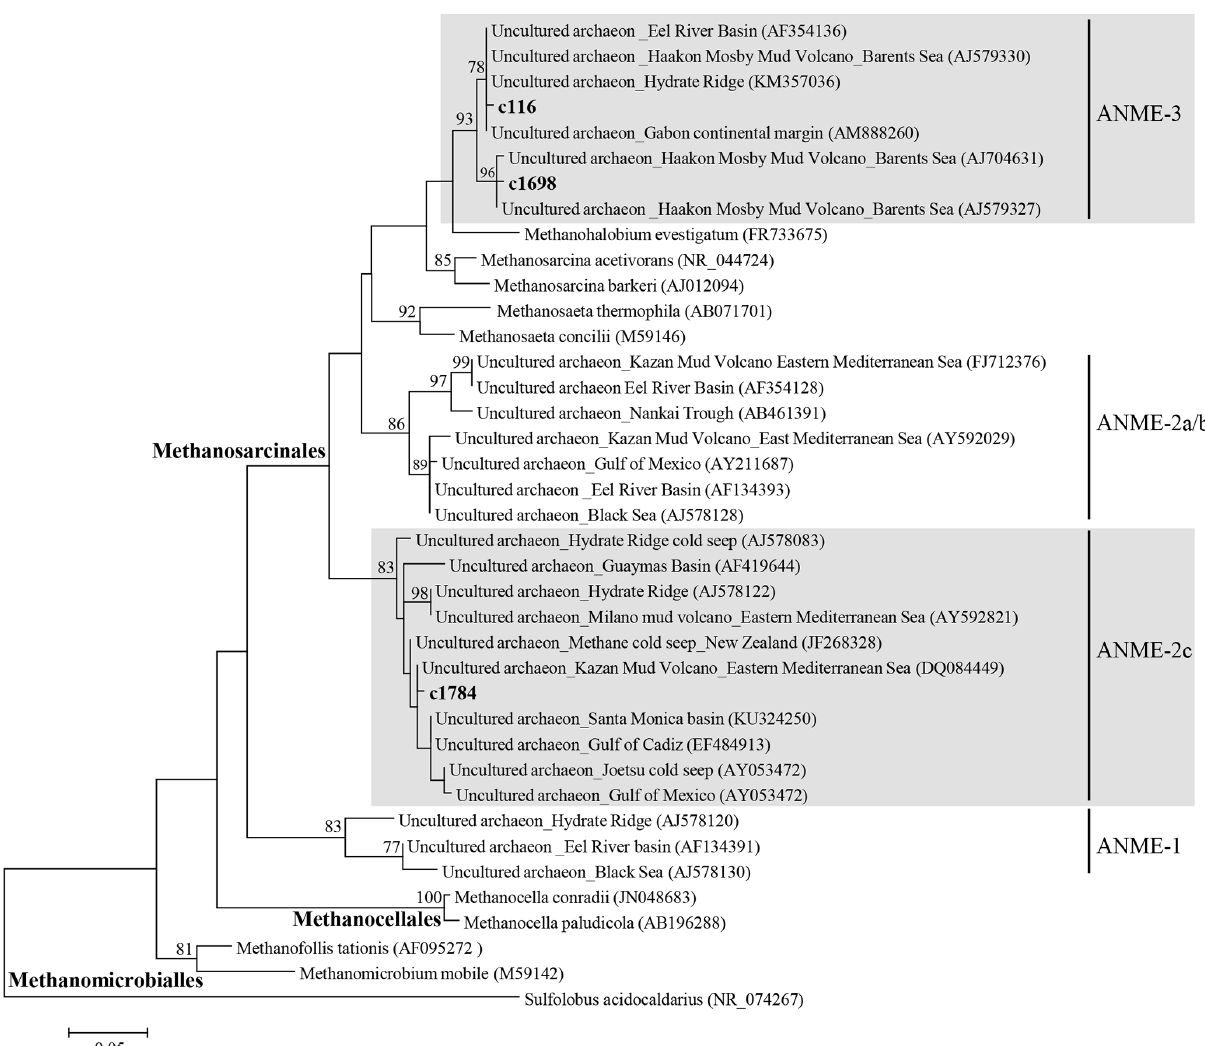
Figure 5. Phylogenetic tree based on 16S rRNA, showing the relationships of methanomicrobial sequences recovered in this study with selected reference sequences of the phylum Euryarchaeota. The phylogenetic tree was inferred by the maximum likelihood method. Bootstrap values of >70 are shown on corresponding branches. The scale bar indicates evolutionary distance of 0.05 substitutions per